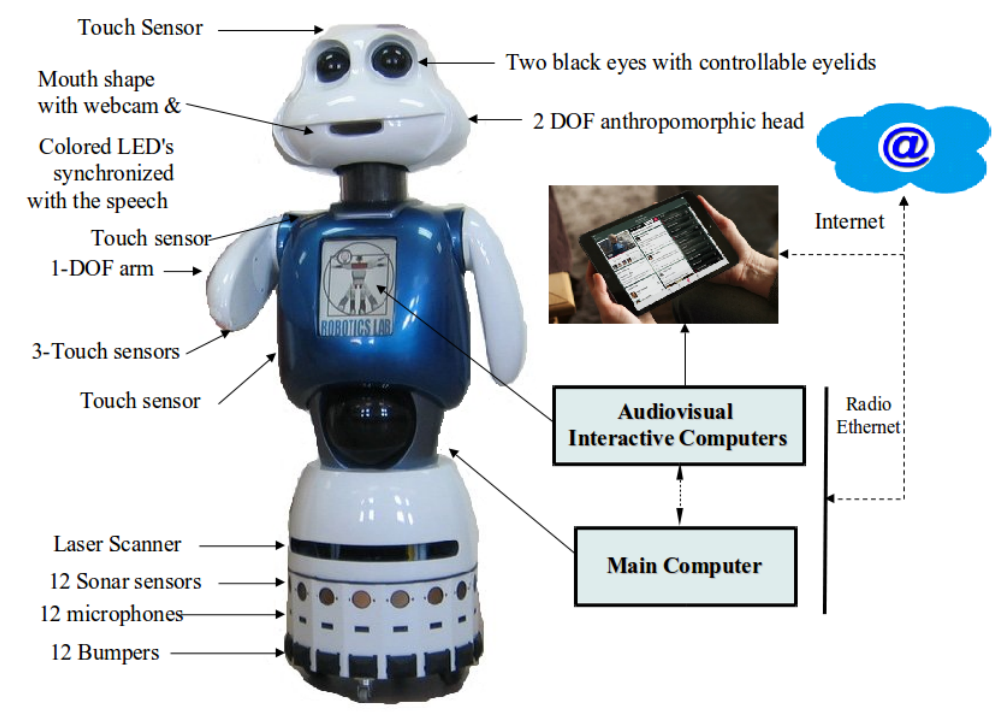
Figure 1. The social robot Maggie with an external interactive